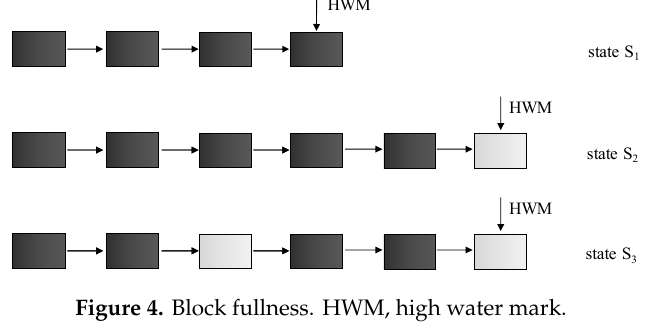
Figure 4. Block fullness. HWM, high water mark.